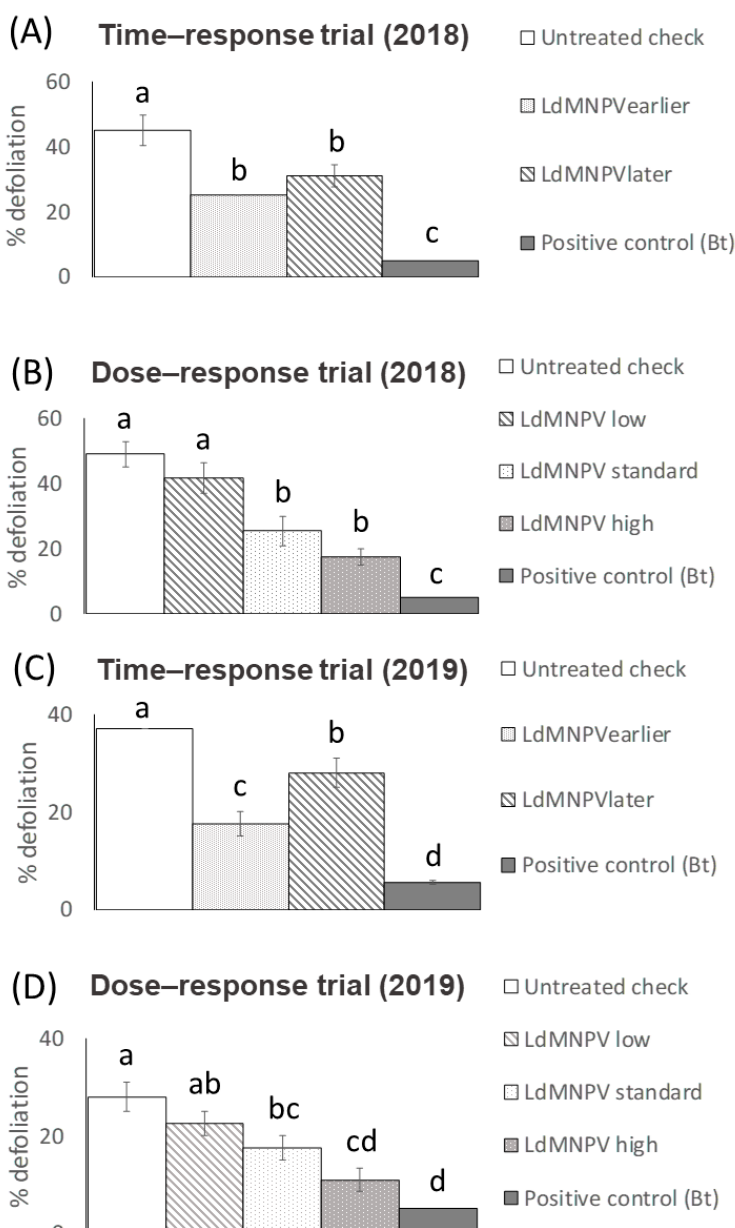
Figure 5. Defoliation percentage (mean ± SE) in different plots treated with LdMNPV from the ground in 2018 ( A , B ) and 2019 ( C , D ). Different letters (a, b, c, d) above bars indicate significant differences among means (ANOVA, Tukey test, p < 0.05).